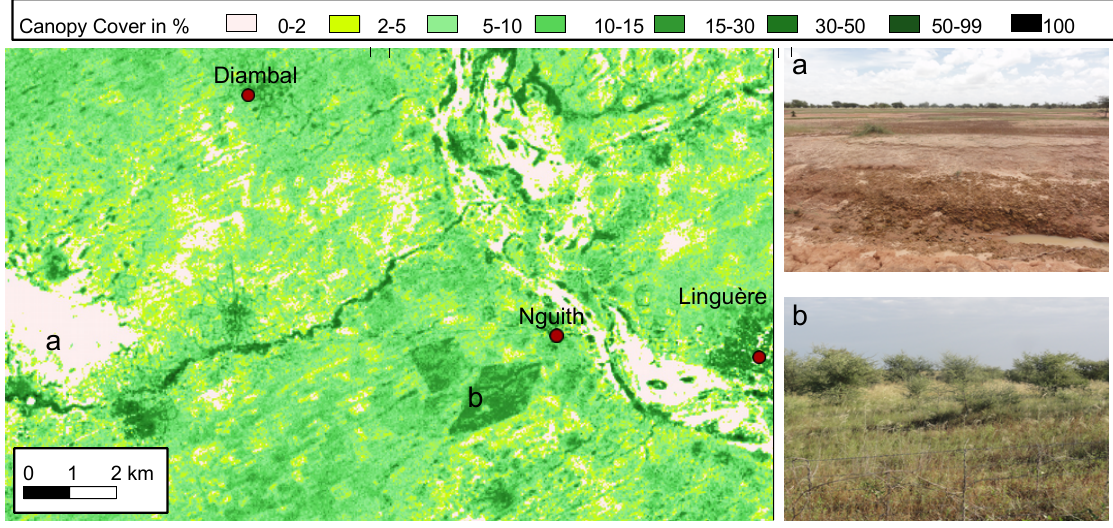
Figure A2. In this detail map of canopy cover west of Linguère two things are striking: ( a ) the degraded area in the west; and ( b ) the densely vegetated area south-west of Nguith which is a fenced area with planted trees. Herders and livestock need a permission to enter and only villagers cultivate few crops inside. Both photos are taken in September